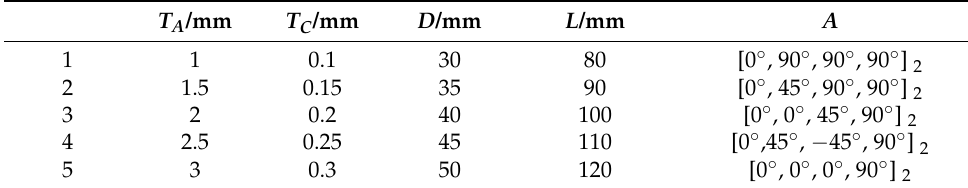
Table 7. Levels of different